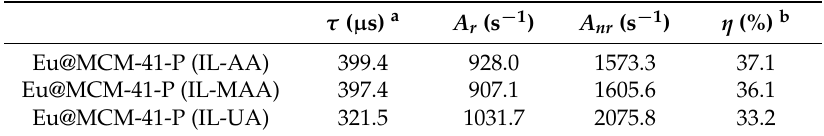
Table 1. Luminescent data for the hybrid materials.